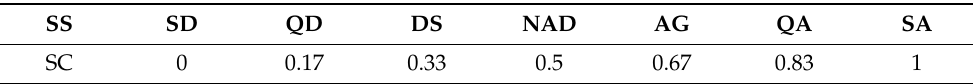
Table 6. Semantic